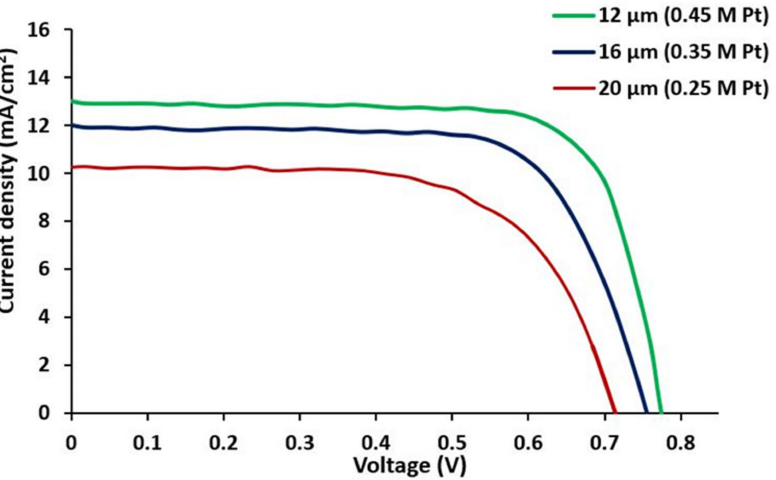
Figure 11. Current density versus photovoltage at three different thicknesses and molar ratios.